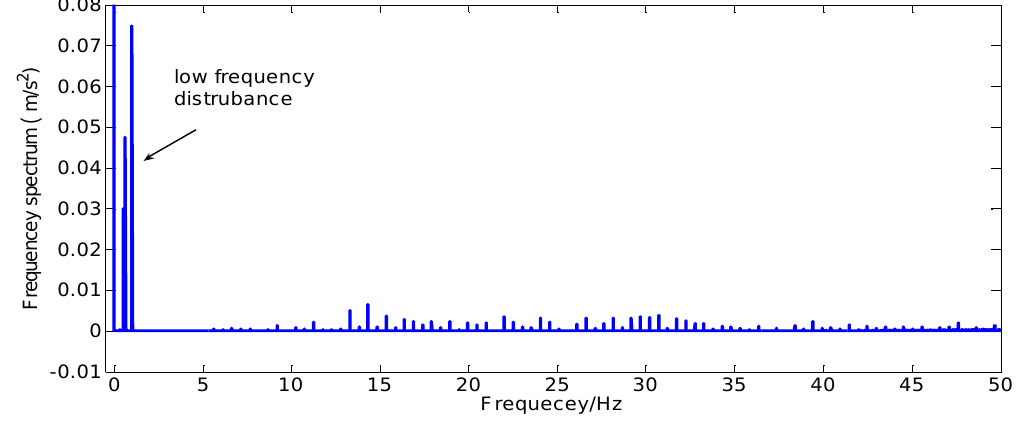
Figure 1. The z axis acceleration frequency spectrum under mooring